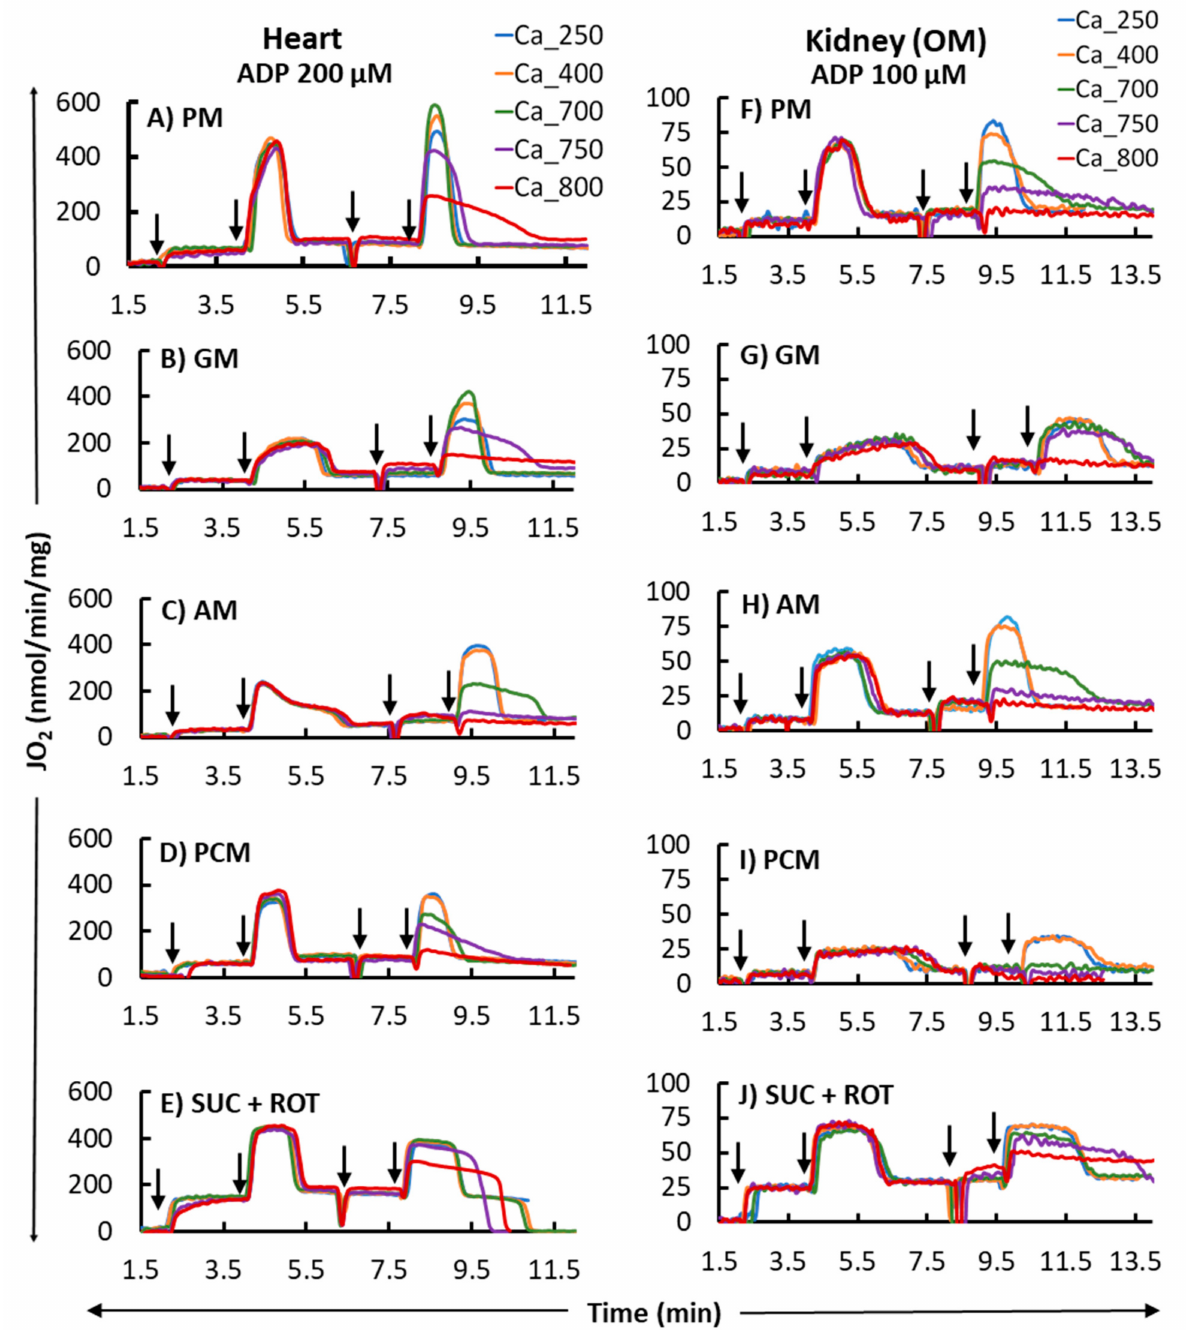
Figure 2. Representative time courses of mitochondrial O 2 consumption rates (OCR; JO 2 ) for different respiratory substrates (PM, GM, AM, PCM, and SUC + ROT) in the heart (left panel; ( A – E ) and kidney OM (right panel; ( F – J ). States 2, 3, and 4 OCR were monitored by adding the substrates at t = 2 min and ADP (200 and 100 µ M final concentration for heart and kidney OM mitochondria, respectively) at t = 4 min, which initiated state 3 respiration proceeding to state 4 respiration after the conversion of the added ADP to ATP. Different concentrations of CaCl 2 (250, 400, 700, 750, and 800 µ M) in the presence of 1 mM Ca 2+ chelator EGTA were added in parallel experiments approximately 1 min after reaching the state 4 respiration, and this was followed by the addition of another ADP with the same concentration as used above. The times at which the reagents were added to the mitochondrial suspension are indicated by the vertical